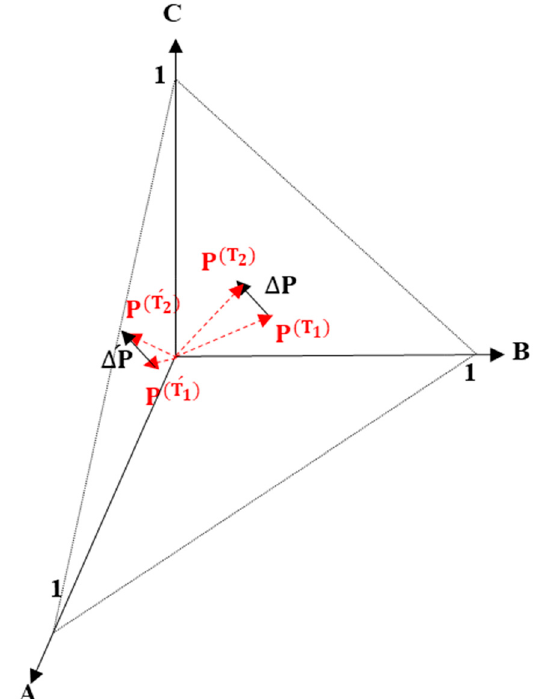
Figure 1. Representation of two change vectors ( ∆ P and ∆ ´ P ) in a posterior probability space having the same measures of direction and magnitude, where ∆ P and ∆ ´ P are change vectors with di ff erent ‘from–to’ classes, and A, B, and C represent class labels.